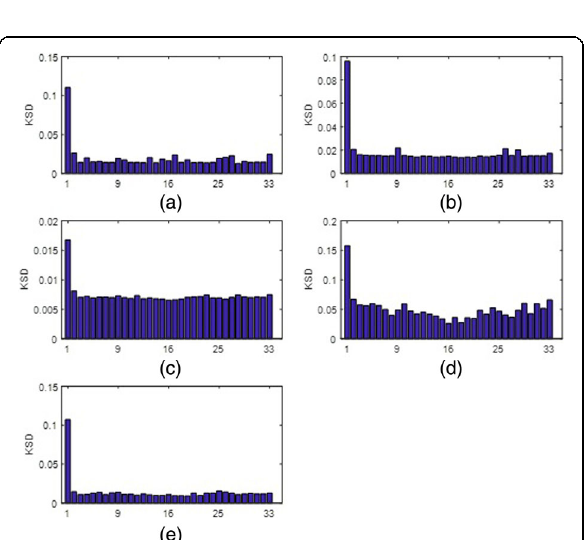
Fig. 16 Average KSD values of each contourlet subband for the alpha-stable distribution. a Brodatz album. b Vistex database. c KTH- TIPS2 database. d Vancouver area image. e San Francisco Bay area